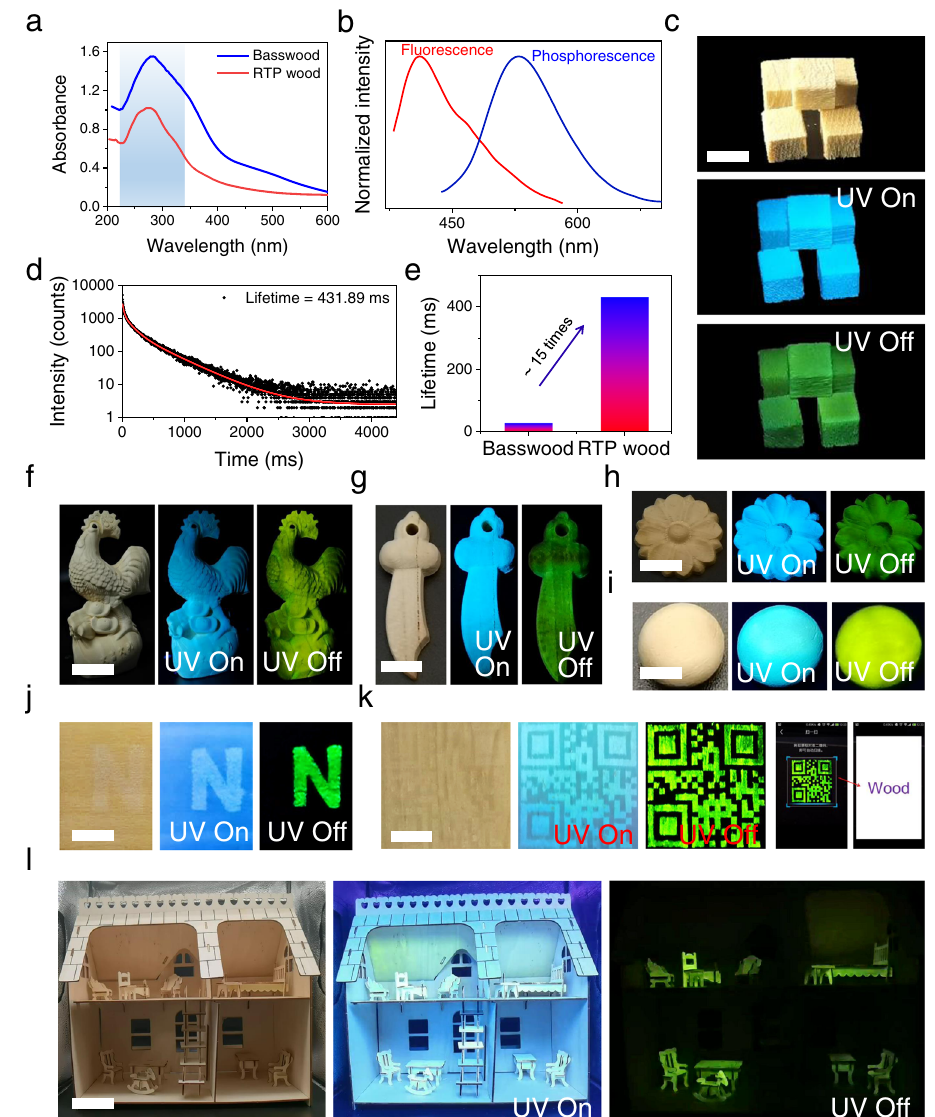
Fig. 4 | Preparation of RTP wood. a UV-Vis spectra of natural Basswood and corresponding RTP wood. b Fluorescence and phosphorescence of RTP wood made from Basswood. c RTP wood made from Basswood under daylight, 365nm UVlamponandoff,scalebar=1cm. d LifetimeofRTPwoodmadefromBasswood. e Comparison between lifetime of natural Basswood and RTP wood made from Basswood. f and g , RTP wood made from peach wood under daylight, 365nm UV